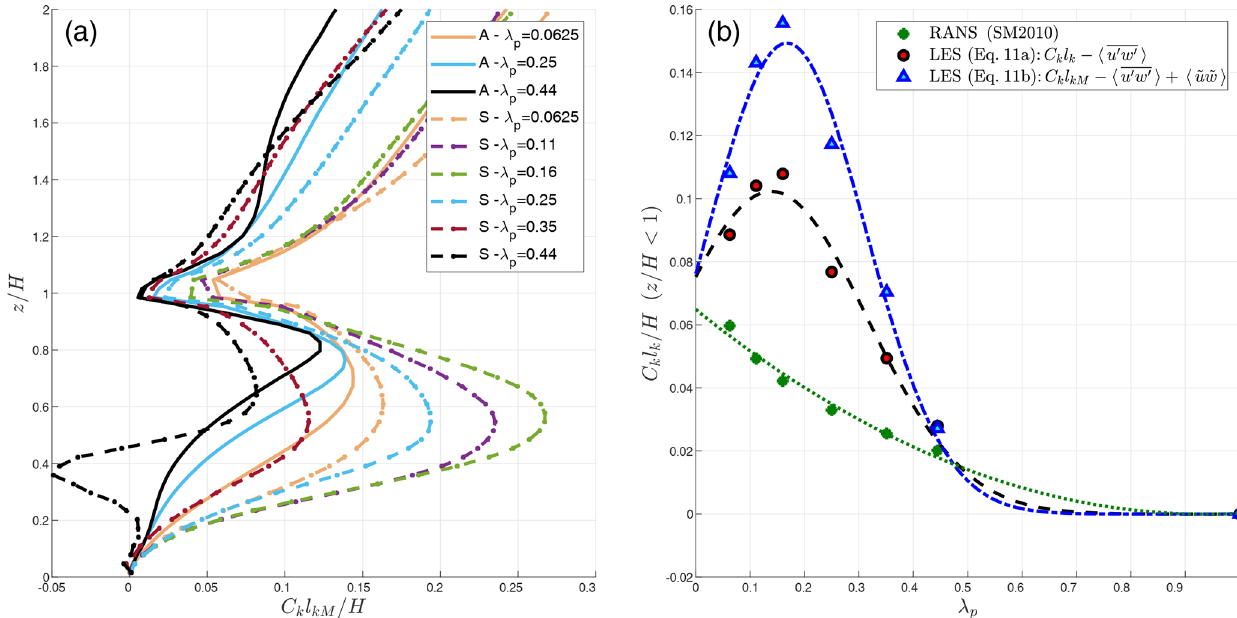
Figure 9. (a) Vertical profiles of turbulent length scale calculated using LES simulations with the dispersive stress included for aligned (A) and staggered (S) urban configurations. (b) Variation in normalized turbulent length scale averaged within the building canyon ( z/H < 1) with plan area density ( λ p ) for staggered configurations. Data points represent (1) the RANS simulation (Santiago and Martilli, 2010), (2) the LES simulation without dispersive stress included, and (3) the LES simulation with dispersive stress